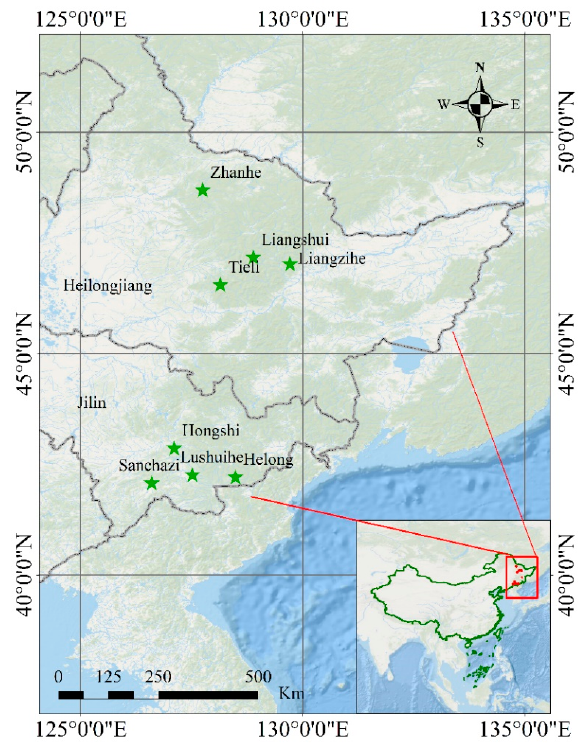
Figure 1. Distribution of the collected samples.